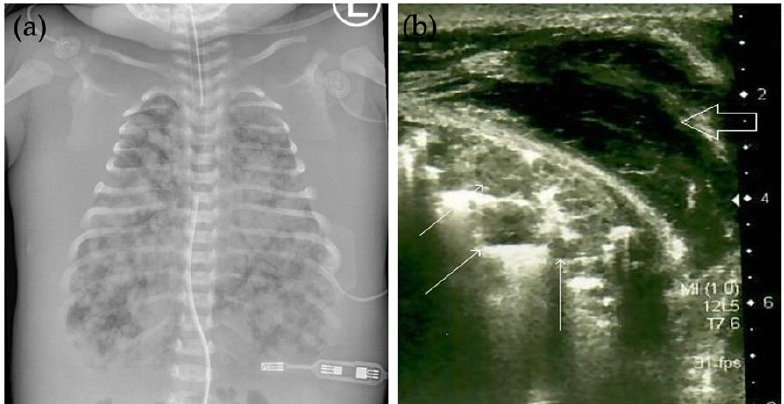
Figure 1. Frontal radiograph and ultrasonography of the lung. ( a ) Frontal chest radiograph shows multiple round lesions of different sizes diffusely involving the entire lung. Generalised body oedema in keeping with hydrops fetalis can be seen. Also noted are endotracheal tube, nasogastric tube, and umbilical venous line. ( b ) Ultrasonography of the lung showed multiple round hypoechoic solid nodules within the lung parenchyma (thin white arrows). No pleural effusion was seen. Severe body oedema is also noted (thick void arrow).